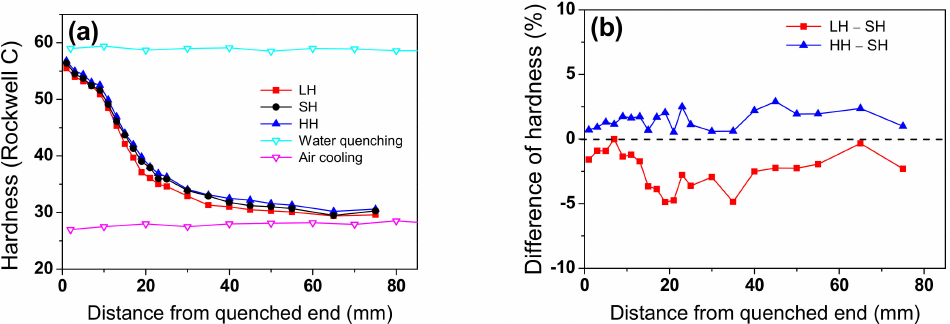
Figure 8. Comparison of ( a ) hardness profiles and ( b ) hardness difference of the Jominy specimen with the different water jet